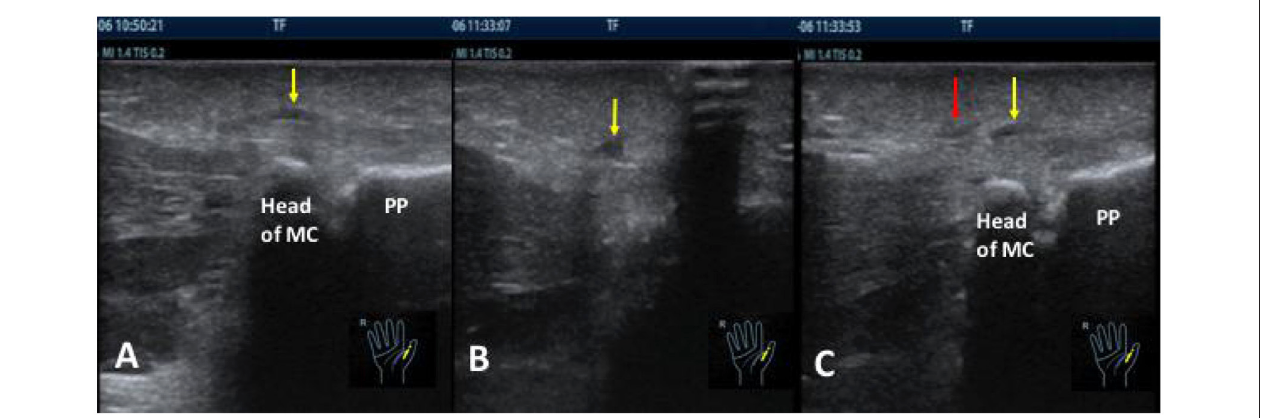
FIGURE 5 | The ultrasound images before (A) and after (B,C) release in the blind group. (A) The yellow arrow showed the thickness of A1 pulley in the right thumb before release. (B) The yellow arrow showed the fluid of the surrounding tissue immediately after release. (C) The red arrow was the wrong cutting direction after piercing into the skin from the marked entry point. The yellow arrow was the thickening location of A1 pulley. They were not at the same point. PP, proximal phalange, MC, metacarpal bone.